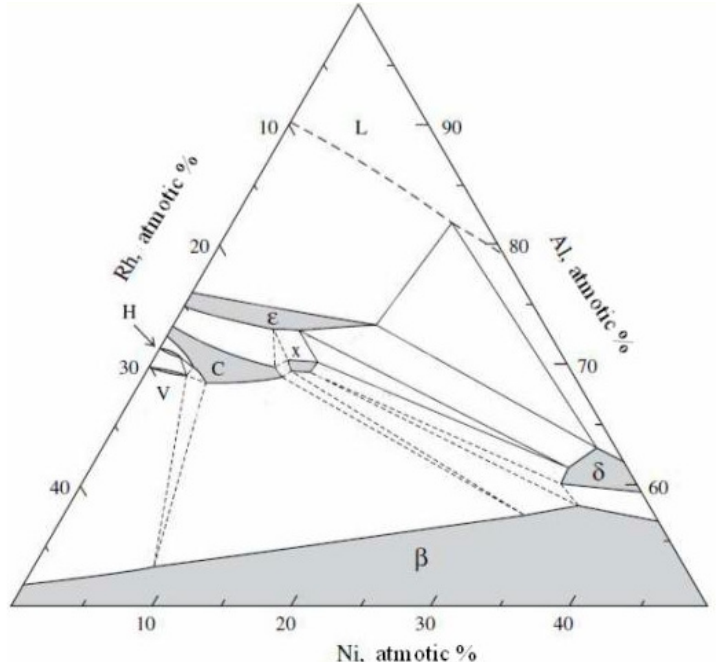
Figure 11. Al–Ni–Rh phase diagram at 1000 °C. Reproduced with permission from [25], published by Elsevier, 2007.